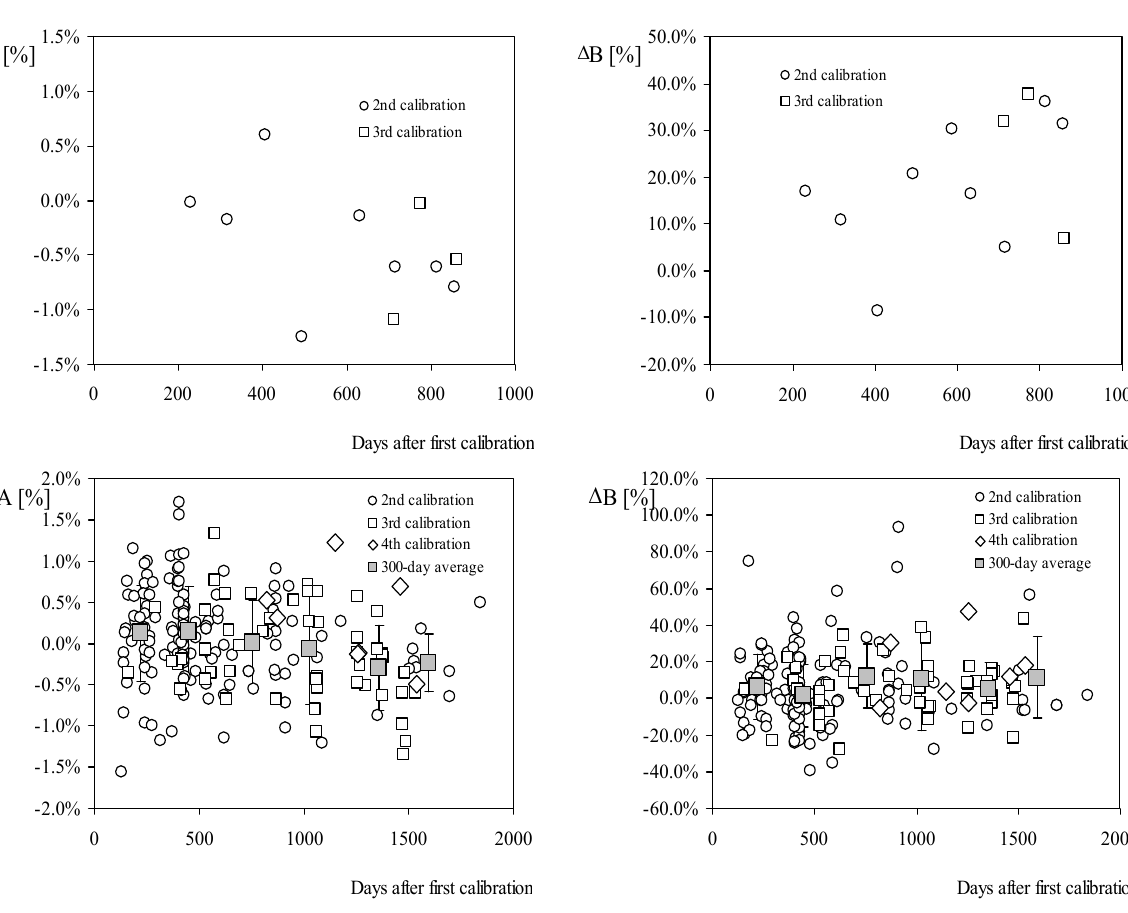
Figure 7. Percentage variation of calibration constants A and B from the initial values with regard to Climatronics 100075 (top), and Vector Instruments A100 LK (bottom) cup anemometers calibrated several times at the IDR/UPM Institute. The 300-day average value, together with the standard deviation bars, have been included for the second model (the data corresponding to the Climatronics 100075 model is clearly not sufficient for an equivalent